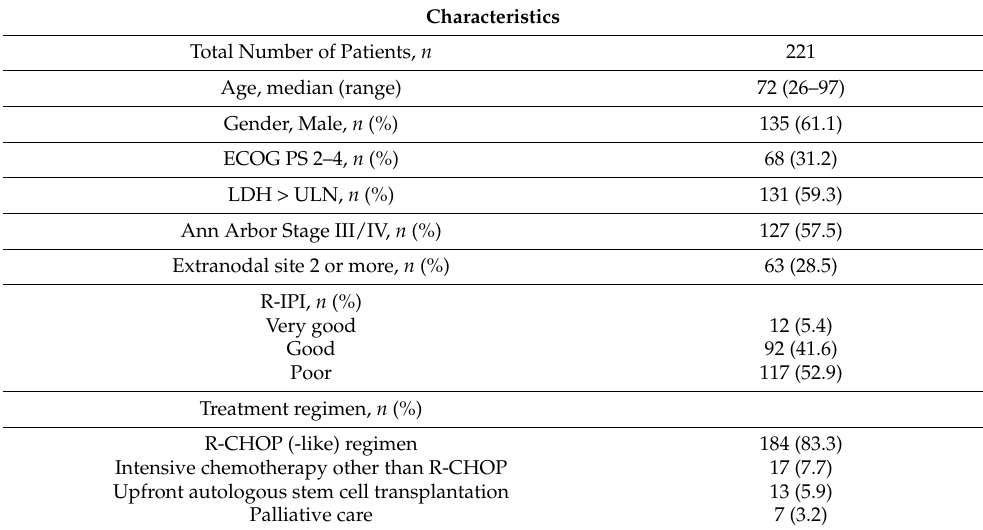
Table 1. Patient